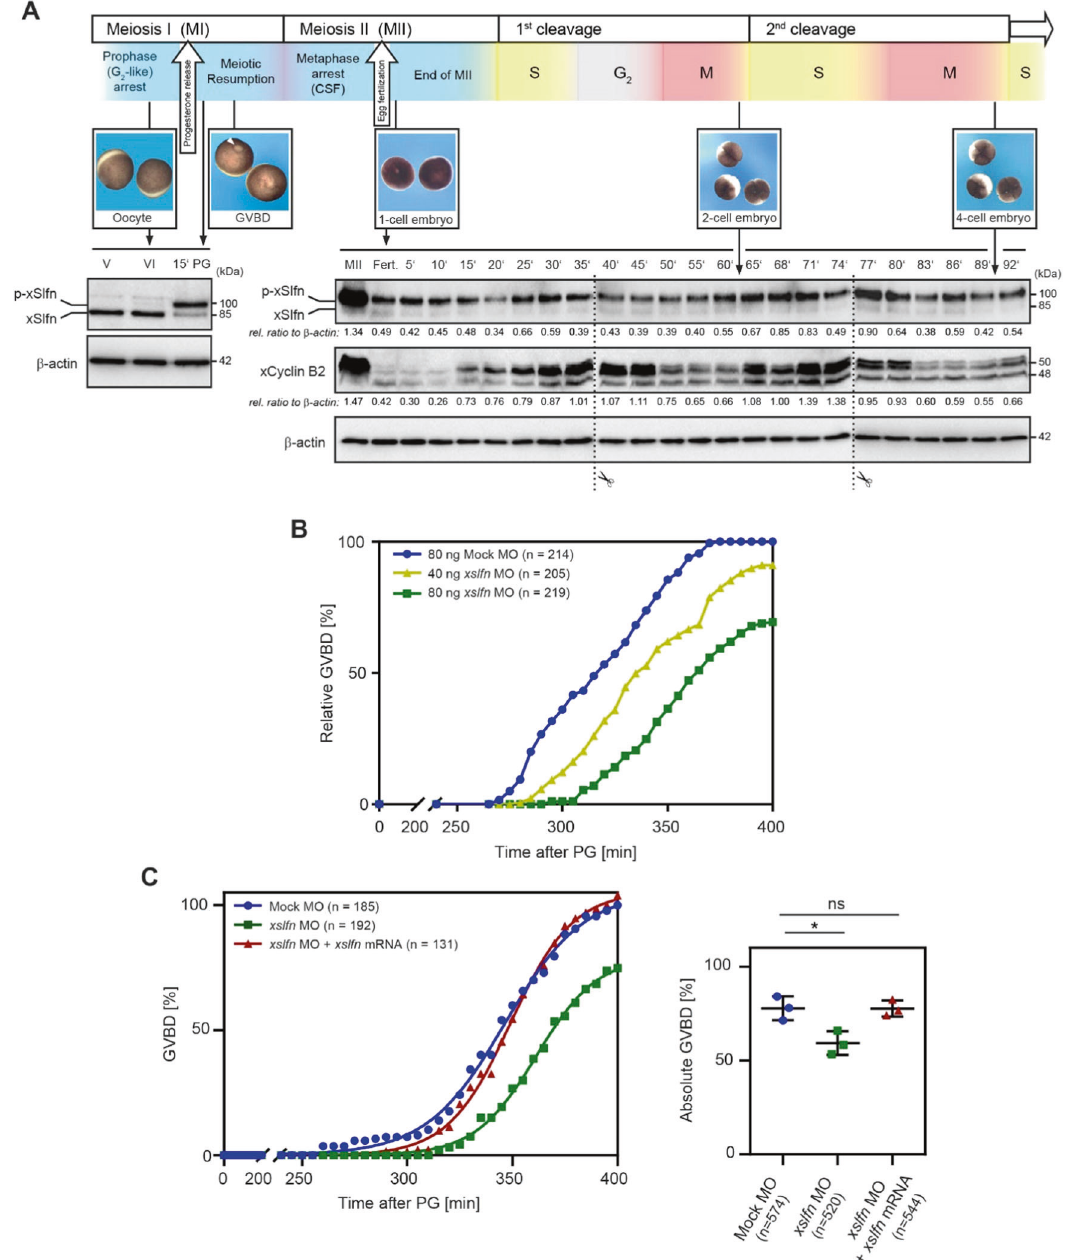
Fig. 4 xSlfn expression oscillates during X. laevis embryonic development and xSlfn loss-of-function delays oocyte meiotic resumption. A Schematic representation of X. laevis oocyte development from stage V to metaphase arrest of meiosis II (MII). Mature stage VI oocytes are arrested in a “ G 2 -like ” -state in prometaphase of the fi rst meiotic division (MI). Only after progesterone (PG) treatment they complete MI and begin MII until a second arrest at metaphase of MII (cytostatic factor arrest, CSF arrest) blocks further progression of development for a second time. Developmental progression is resumed at fertilization, when completion of the second meiotic division and start of fi rst embryonic cell divisions take place (upper panel). For immunoblotting, oocytes and embryos were collected at different developmental stages and expression of xSlfn and phosphorylated xSlfn (p-xSlfn) was assessed using an antibody to xSlfn. Fertilization was assessed by the appearance of cortical rotation. Cyclin B2 was used as a marker for G 2 and M phase. β -actin was used as loading control. The Western blot shows a representative time course from three independent collections. B , C xSlfn loss-of-function delays meiotic resumption. Microinjection of antisense Morpholino targeting the 5 ′ -UTR of xslfn delays the progression from G 2 -phase/prophase of MI to metaphase of MII after progesterone treatment in a dose-dependent manner ( B ) and can be rescued by co-injection of non-targetable xslfn mRNA ( C ). Oocytes injected with Mock-Morpholino (MO) served as a control. In C , the left panel shows a representative experiment from three independent experiments. The right panel depicts the overall number of oocytes reaching GVBD. Each data point represents one independent replicate. * , P < 0.05; ns, not signi fi cant (Two-sided Student´s t -test).